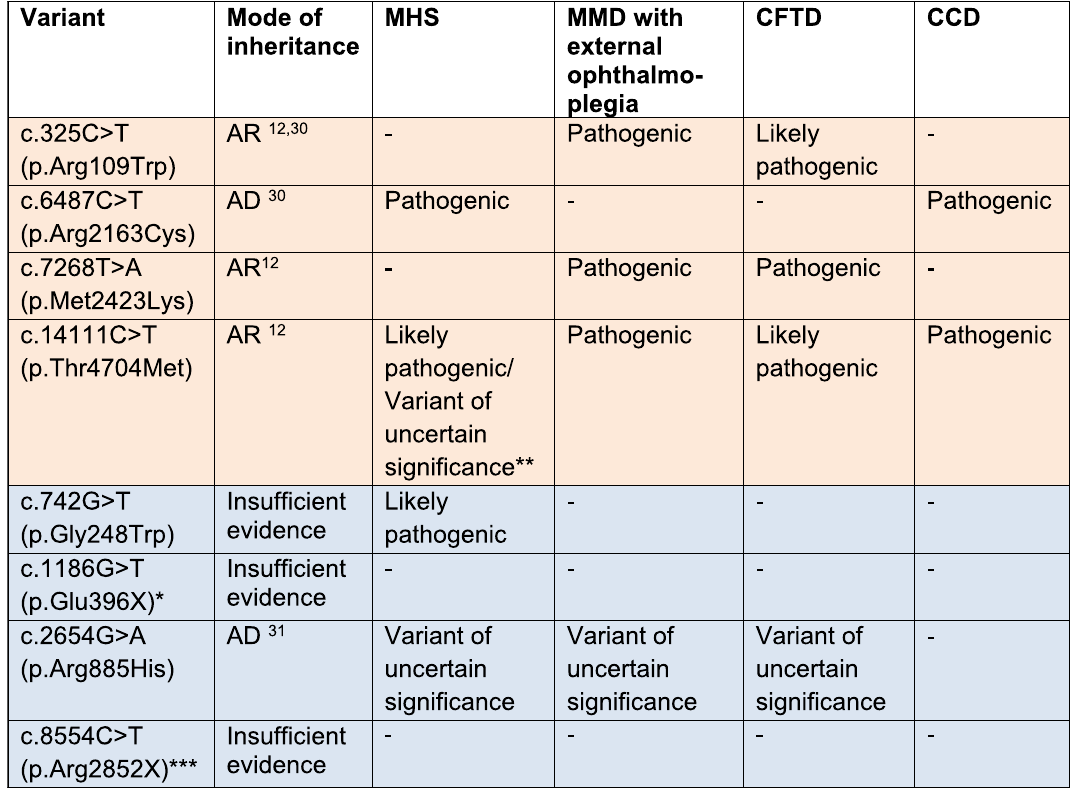
Table 2. RYR1 variants and their clinical significance (pathogenicity, mode of inheritance) in relation to MHS and congenital myopathies. MHS: malignant hyperthermia susceptibility; MMD: multiminicore disease; CCD: central core disease; CFTD: congenital fibre-type disproportion; AR: autosomal recessive; AD: autosomal dominant. *Not found in ClinVar. Labelled as pathogenic in InterVar. **Various submitters to ClinVar provided different clinical significance for this variant in relation to MH-susceptibility. ***Labelled as Variant of uncertain significance for RYR1-related disorders in ClinVar. Disorders were not specified. “–”: No information regarding the clinical significance of the RYR1 variant in relation to this